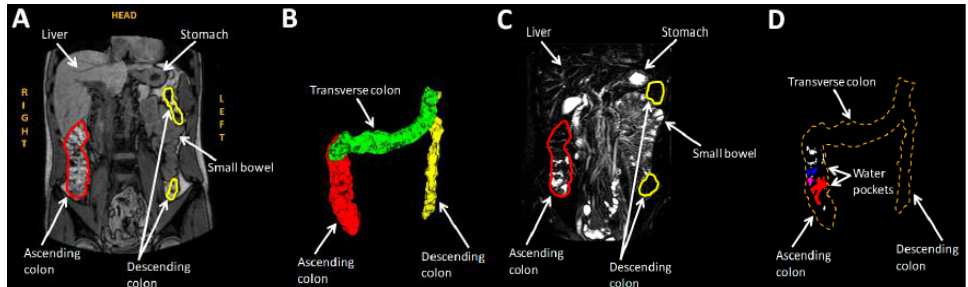
Figure 4. ( A ) Example of a coronal plane anatomical MRI abdominal image. Visible sections of the colon are highlighted. ( B ) Example 3D reconstruction of the colon. Red, green, and yellow differentiate the ascending, transverse, and descending colon, respectively. ( C ) Fluid-selective MRI image corresponding to ( A ); freely mobile liquid appears white, whereas less mobile fluid and tissues appear dark. ( D ) Extraction of freely mobile water pockets in the colon. Reproduced with permission from Molecular Pharmaceutics , 14, Murray et al., “Magnetic Resonance Imaging Quantification of Fasted State Colonic Liquid Pockets in Healthy Humans”, 2629–2638 [26] (https://pubs.acs.org/doi/10.1021/acs.molpharmaceut.7b00095, accessed on 21 February 2021), Copyright American Chemical Society (2017); further permissions related to the material excerpted should be directed to the